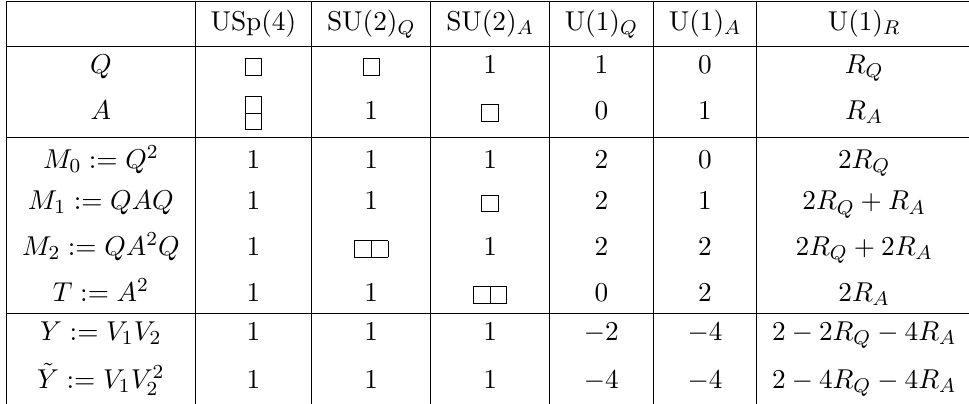
Table 6 . Quantum numbers of USp(4) with two anti-symmetrics and two fundamentals. coordinates are related in the following